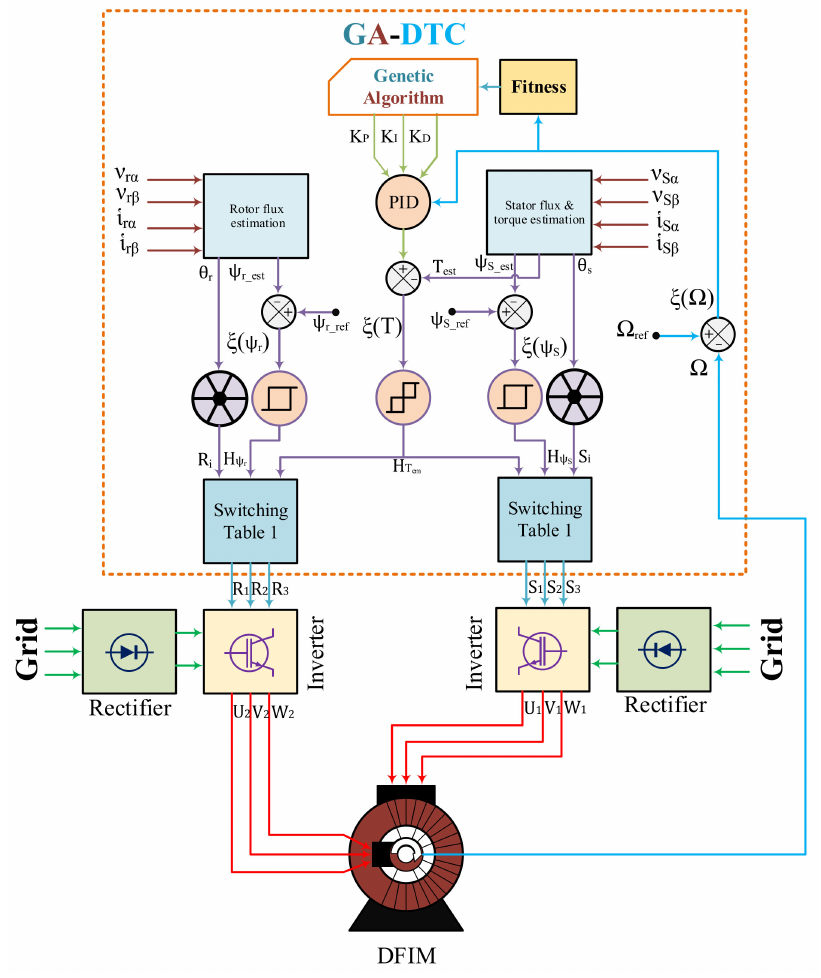
Figure 3. GA-DTC control schematic applied to